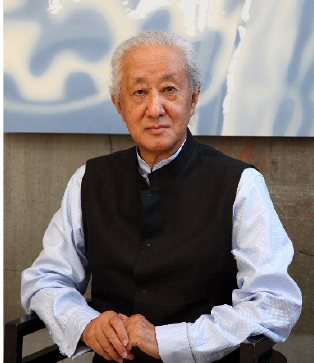
Figure 5. Portrait: Arata Isozkai (born 1931 in Oita, Japan), photo around 2015 (Courtesy: Arata Isozaki & Associates, Tokyo).